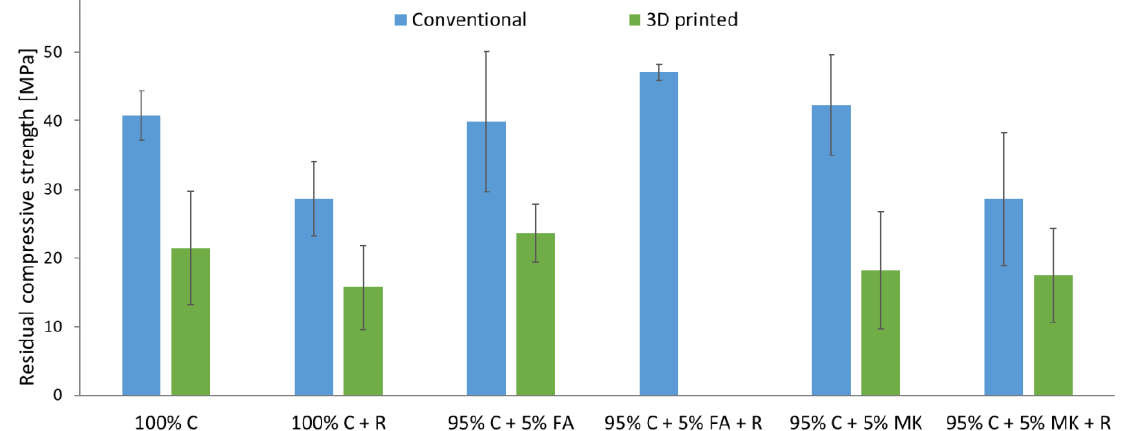
Figure 5. Residual compressive strength after the freeze–thaw cycles of concrete and concrete– geopolymer hybrids produced by casting and 3D printing.